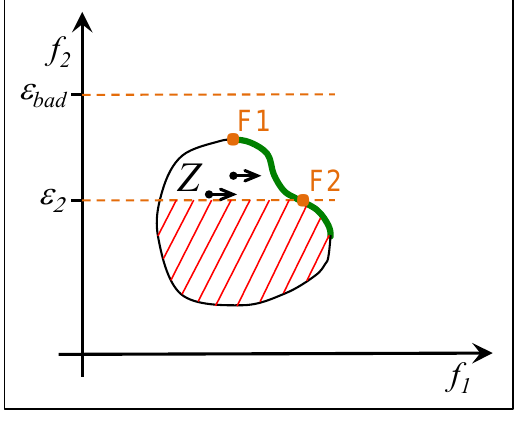
Figure 5. Restricted objective region using the ε -constrained method. The hatched region is excluded due to the lower bound ε . The remaining Pareto front is limited by F1 and F2 . 2 For too large bounds like ε , the problem becomes bad